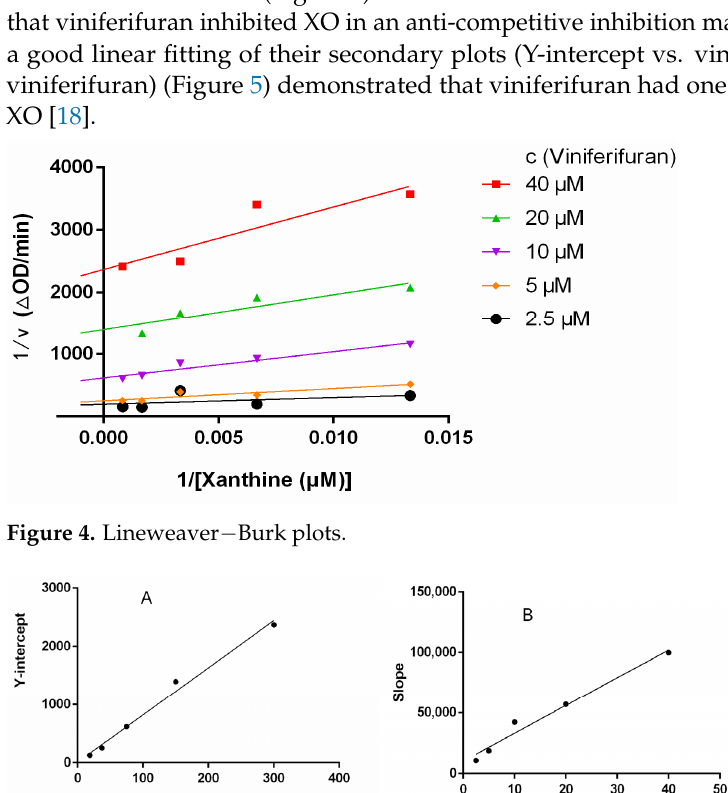
Figure 3. Plots of ν vs. XO. Each point is the mean of three independent determinations.